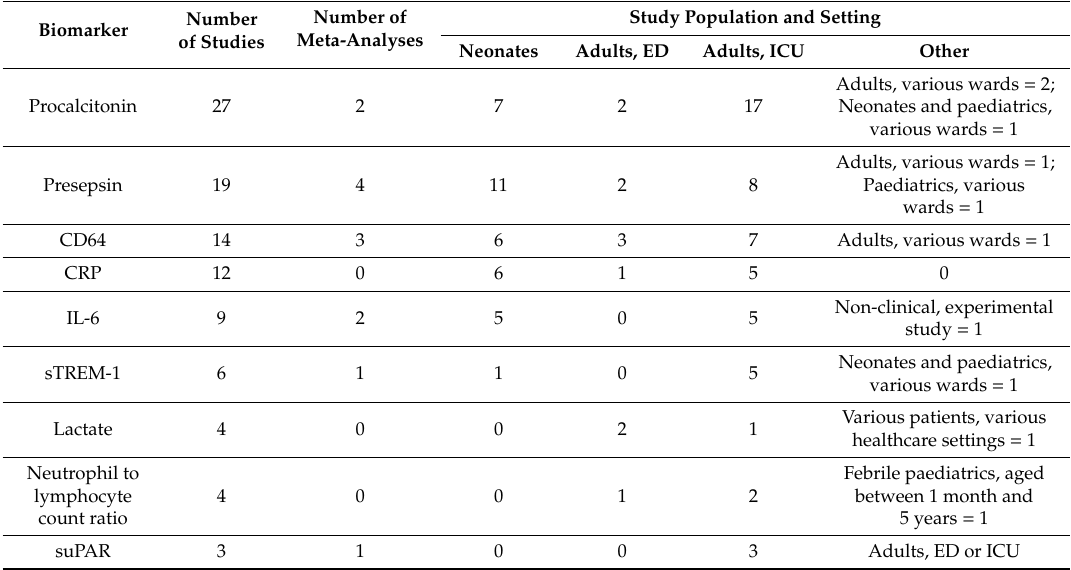
Table 6. Summary of the nine biomarkers most studied for sepsis diagnosis, as identified by the current literature